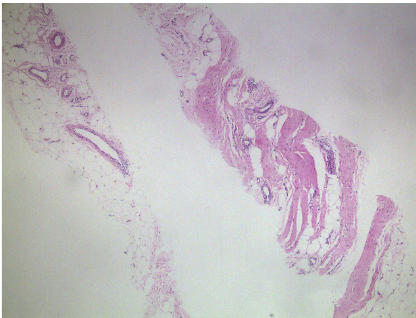
Figure 2: Histopathologic changes of synovial biopsy. Histopatho- logic examination of synovial biopsy revealed multiple villi having fatty core lined by hyperplastic synoviocytes with chronic inflam- matory cell infiltration (hematoxylin and eosin stain 4x).